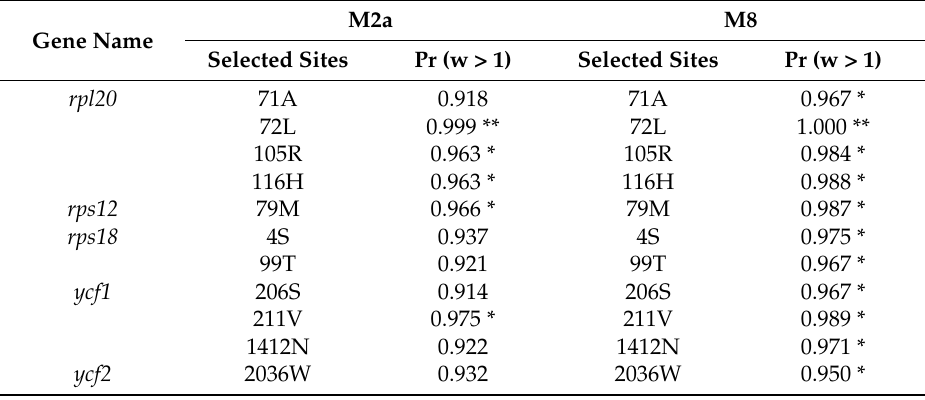
Table 4. Positive selected sites detected in the cp genome of the Piperales.